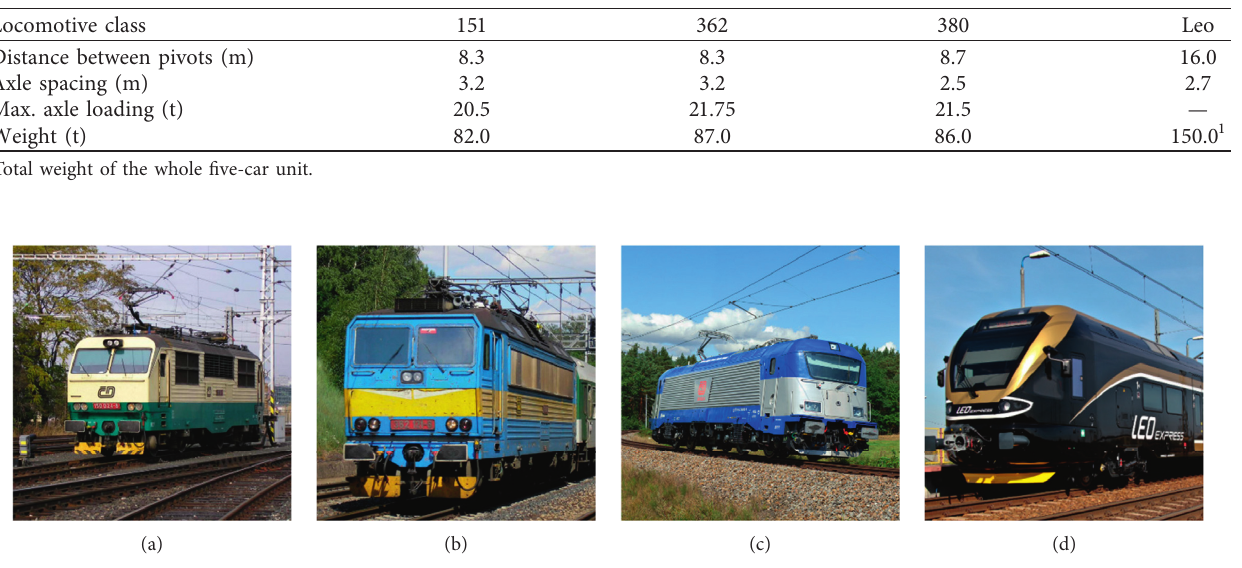
Table 1: Mechanical properties of the trains.